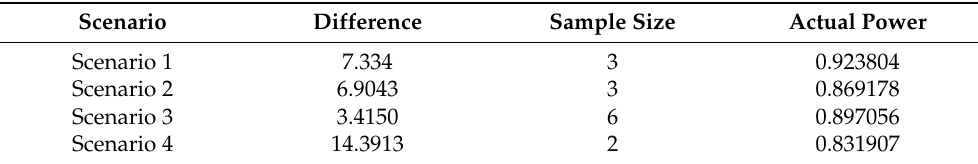
Table 12. Updated results of power and sample size estimation.